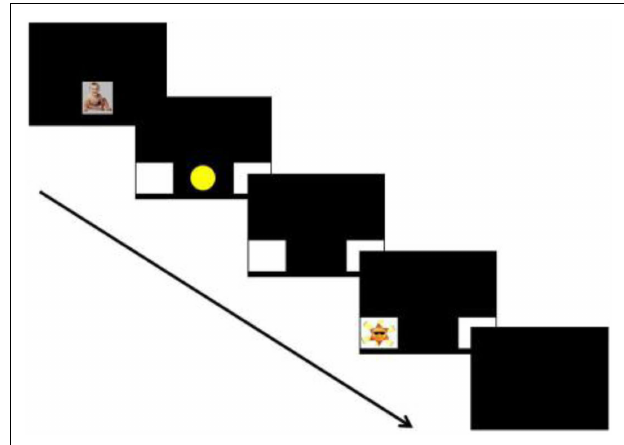
FIGURE 1 |The structure of an individual trial. See text for the duration of each slide.